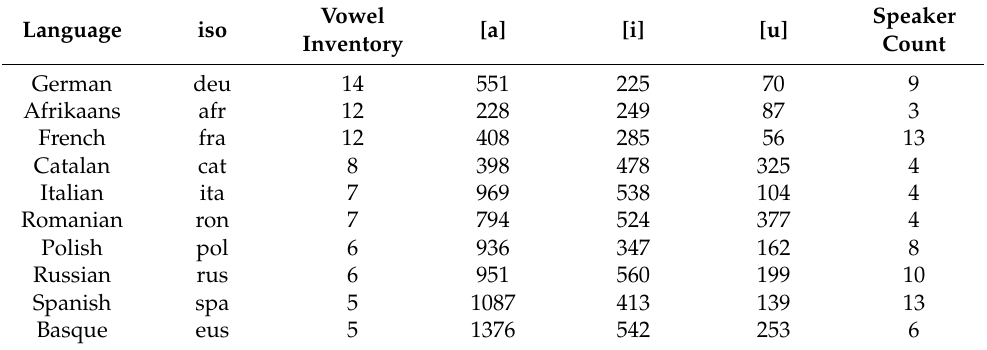
Table 1. Count of the vowels [a], [i], and [u] in a sample of 1000 recordings for each language in the data set. The vowel inventory refers to the number of timbres in each language.